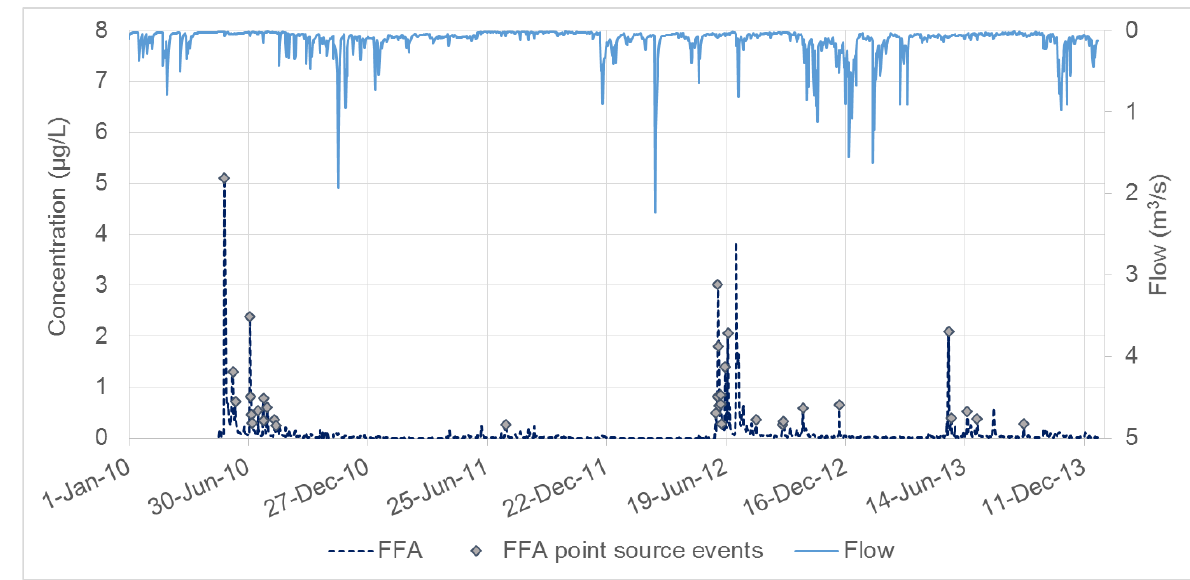
Figure 2. FFA concentrations and previously identified point